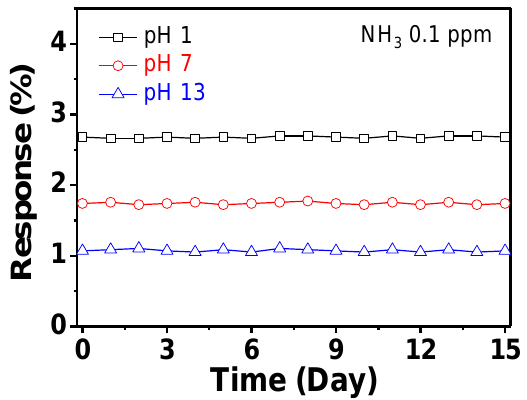
Figure 8. ( a ) Change in normalized resistance with different MeOH concentrations. ( b ) Calibration curves of PPyNPs as functions of NH 3 and MeOH concentrations; black for pH 1, red for pH 7, and blue for pH 13. ( c ) Periodic exposure of PPyNPs treated at pH 1 to 10 ppb of NH 3 gas.